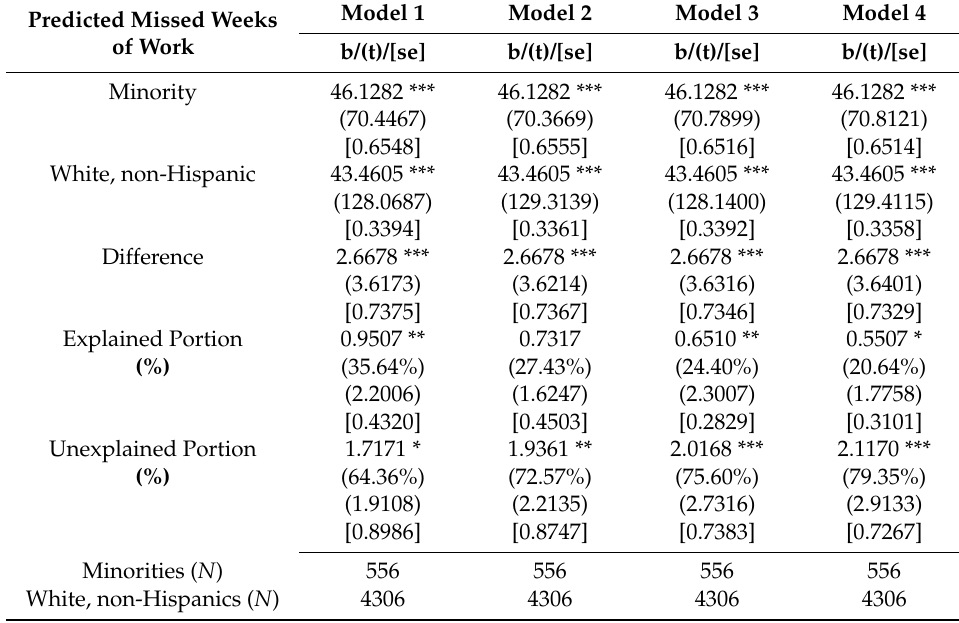
Table 5. Blinder–Oaxaca decomposition of difference in weeks missed due to illness, between Non-Hispanic Whites and minorities, ages 16–65